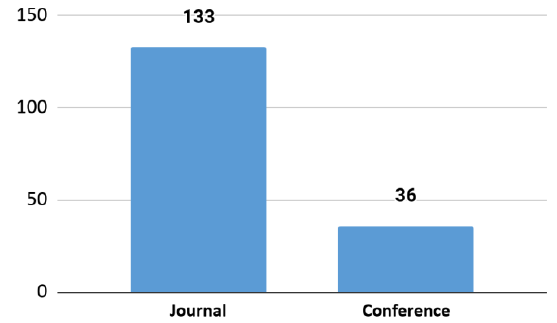
Figure 10. Distribution of where studies are published.